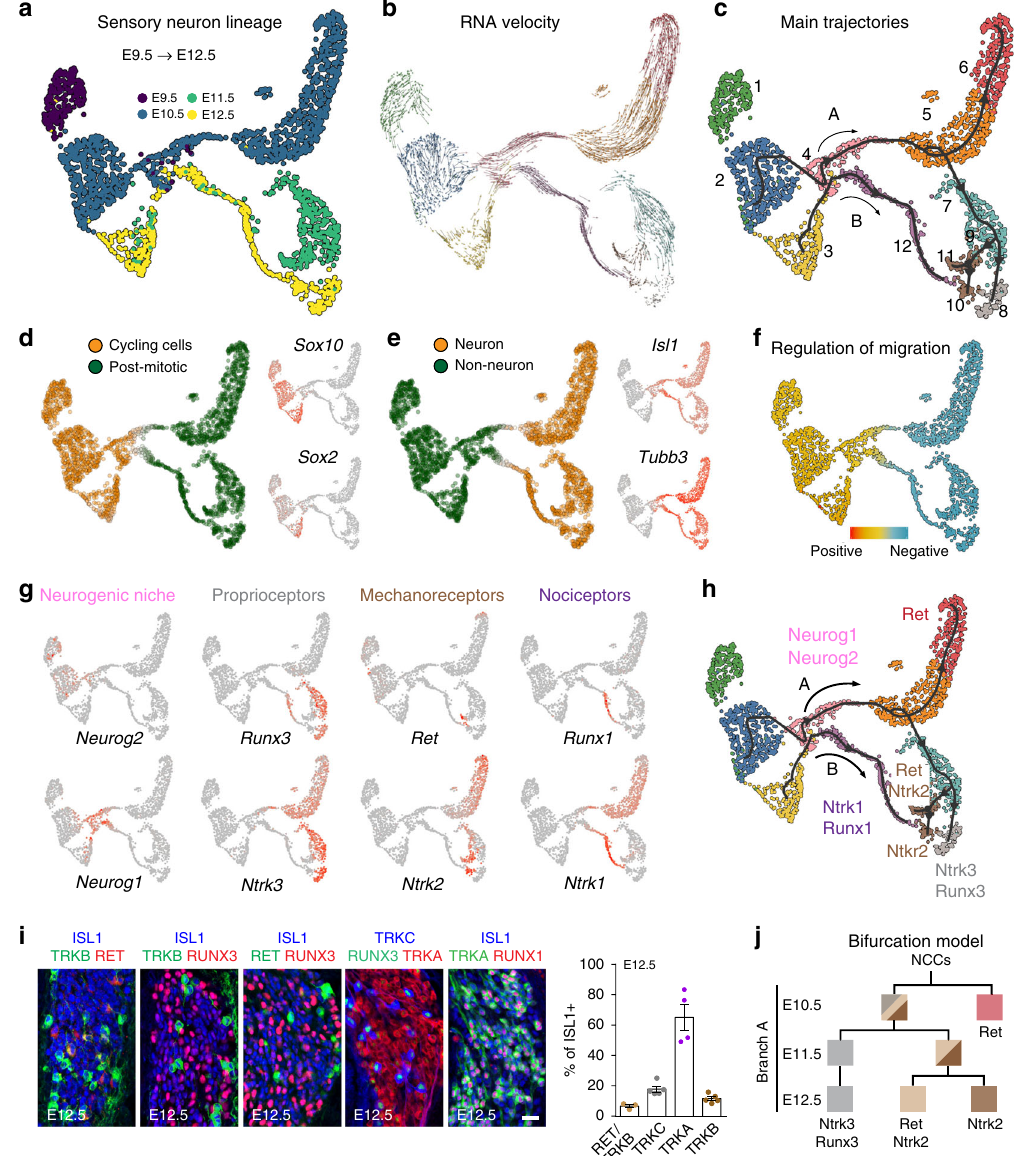
Fig. 1 scRNAseq and pseudotime analysis of the developing somatosensory system. a UMAP embedding representation of the single-cell RNA sequencing dataset, annotated by embryonic day. b RNA Velocity vectors projected onto the UMAP embedding, indicating differentiation directionality. c Differentiation trajectories inferred in a semi-supervised way on Diffusion space using ElPiGraph, revealing 12 main clusters represented within two main trajectories (branches A and B), 10 branches and 3 bifurcations (1, 2 and 3) on branch A. List of genes is provided in the Source data fi le. d , e Most signi fi cant biological aspects extracted using pagoda2 indicate cell state changes from cycling ( Sox10 + and Sox2 + ) to post-mitotic cells ( d ) and from non- neuronal to neuronal cells ( e ) ( Isl1 + and Tubb3 + ). f PC score from gene set related to GO term “ positive regulation of cell migration ” (GO:0030335) subtracted by the PC score for “ negative regulation of cell migration ” (GO:0030336) indicates a transition from migratory neural crest progenitors to settling neuronal populations. g UMAP plots of selected genes distributed along the trajectories and among cells states represented in ( c – e ). h Transcriptomic dynamic during neurogenesis and neuronal speci fi cation show that the different states account for the differentiation of sensory sub- classes that can be distinguished based on their speci fi c expression of neurotrophic factors receptor and transcription factors ( Ntrk1 , Ntrk2 , Ntrk3 , Ret , Runx1 and Runx3 ). i E12.5 DRG sections immunostained for markers highlighted in ( h ) representing major sensory subpopulation at the trajectories endpoints and quanti fi cation ( n = 3 − 5). Scale bar, 20 µ m. Data are presented as mean values ± SEM. j Hierarchical bifurcation model of NCCs-derived sensory neurons differentiation within Branch A based on our scRNAseq data analysis (color code and cluster identity according to panel h ). Mixed color squares re fl ect the potential fate choice that the lineage retains at the corresponding developmental incorporated EdU (cycling cells) and did not co-localize with the and negative (GO:0030336) regulation of cell migration GO post-mitotic neuronal marker ISL1 (Supplementary Fig. 3a). term gene sets showed a transition from migratory NCCs to Similarly, β III-tubullin staining labeled sensory neurons and did neuronal progenitors (Fig. 1f). Interestingly, as NCCs migrate and not co-localize with SOX2 + cells, which were also EdU + coalesce into sensory ganglia in vivo, they showed enriched (Supplementary Fig. 3b). PC scores for positive (GO:0030335) expression of genes associated with interactions with the local